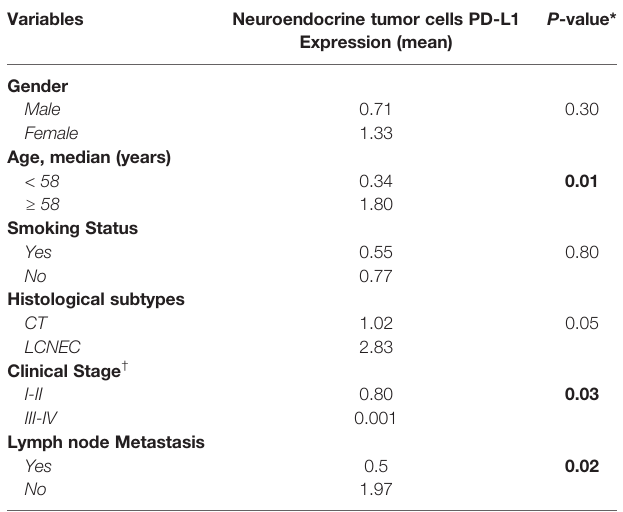
TABLE 2 | Correlation between PD-L1 expression in neuroendocrine tumor cells and clinicopathological characteristics of PNENs patients, by Mann-Whitney test,